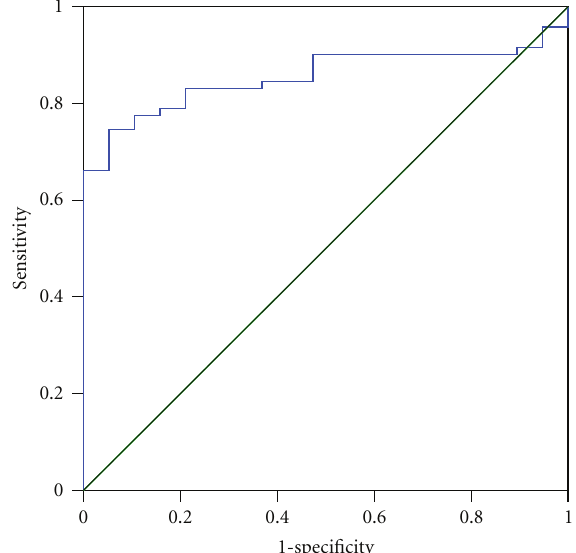
Figure 2: Receiver operating characteristic curve (ROC Curve) of sTREM-1 for asthma bronchiale.